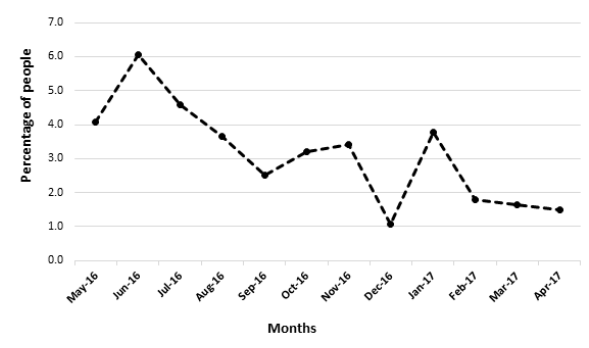
Figure 3 . Number of People Who Went out of Station to Non-malarious Areas (OS-O) Categorized by Different Age Groups.